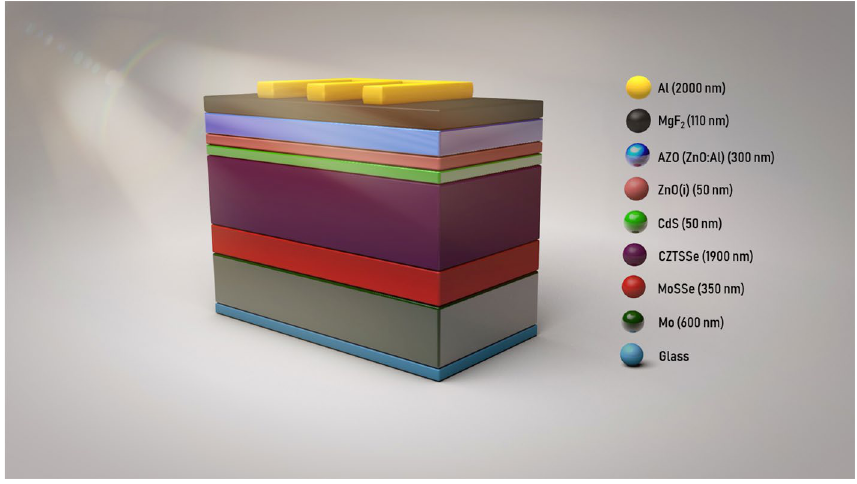
Figure 1. Schematic image of CZTSSe solar cell